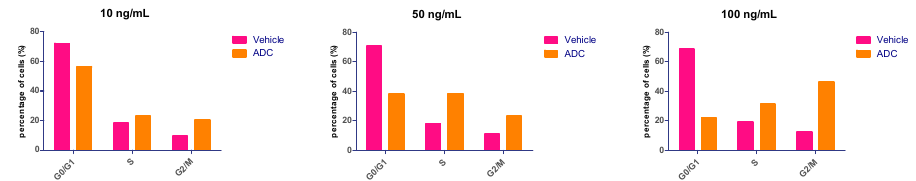
Figure 7. The e ff ects of the ADC (mil40-6) on cell cycle arrest. The BT-474 cells cycle arrest results analyzed by flow cytometry (FCM). ADC was tested in three doses of 10 ng / mL, 50 ng / mL, and 100 ng / mL. The concentration of the ADC is calculated as the concentration of the antibody.